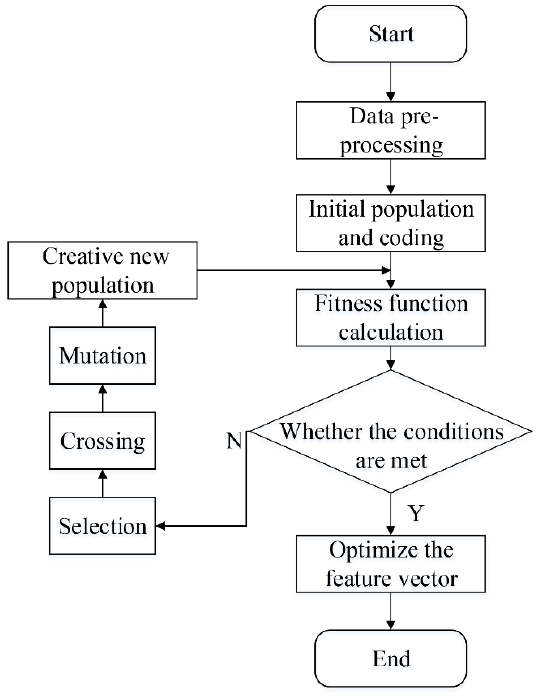
Figure 4. GA-BP flow chart.